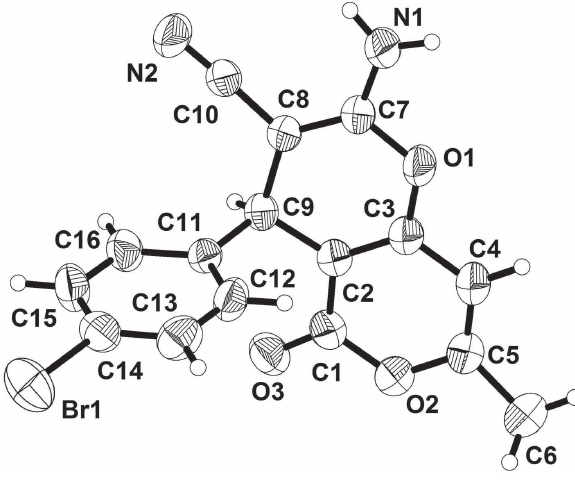
Table 1: Data collection and